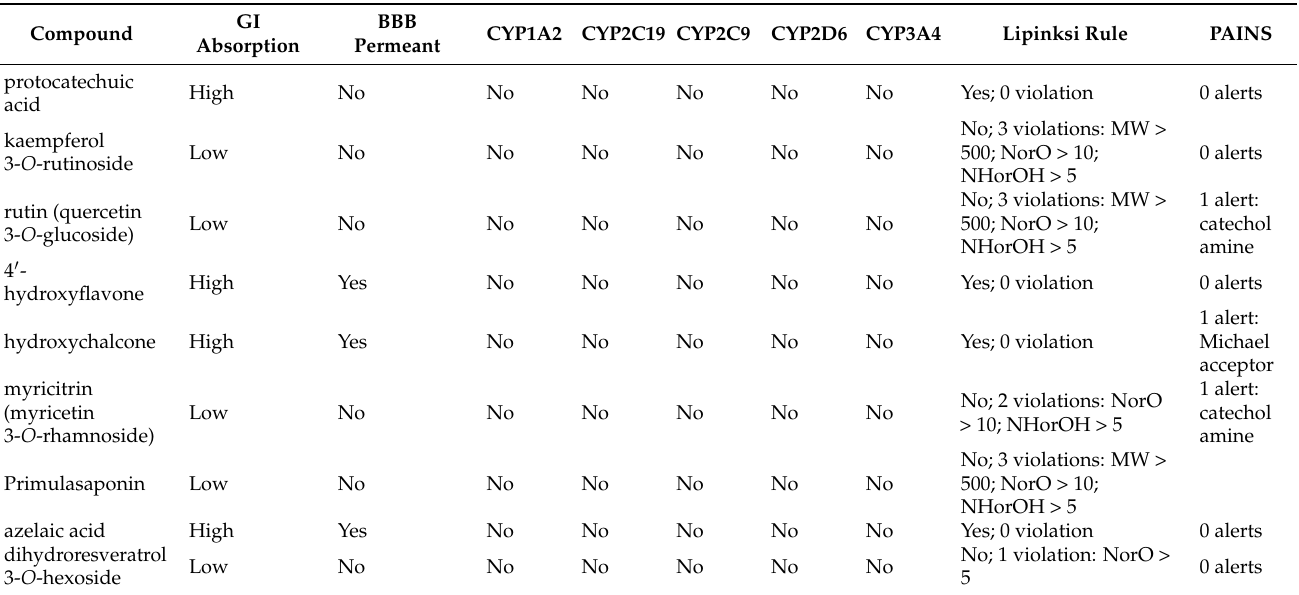
Table 6. Drug-like and ADMET properties of the most abundant compounds in P. auriculata extracts predicted using the SwissADME